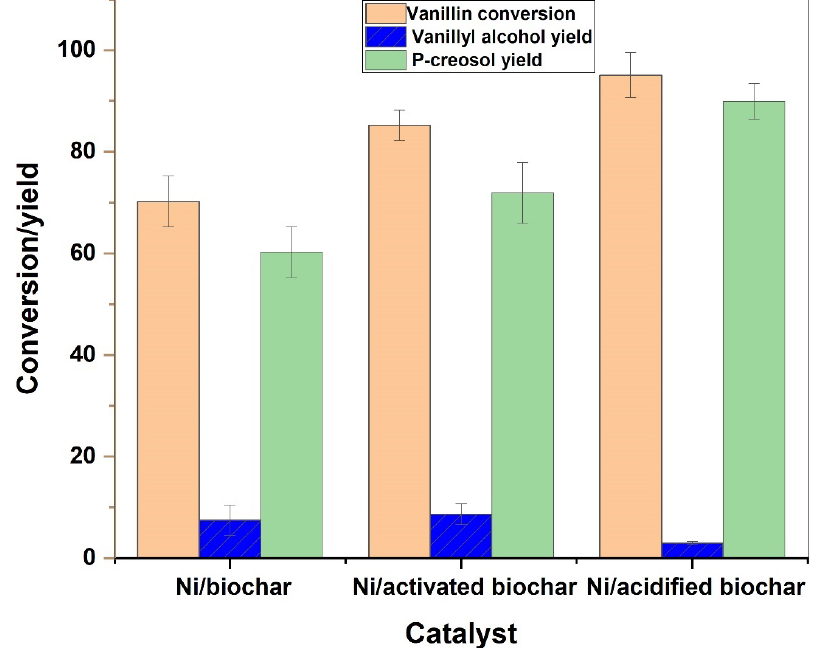
Figure 13. The effect of chemical treatment of biochar on catalytic performance (reaction conditions: initial substrate concentration 0.33 M, temperature 150 °C, H 2 pressure 50 bar, catalyst 0.8 g, reaction initial substrate concentration 0.33 M, temperature 150 ◦ C, H 2 pressure 50 bar, catalyst 0.8 g, reaction time 7.5 h). time 7.5